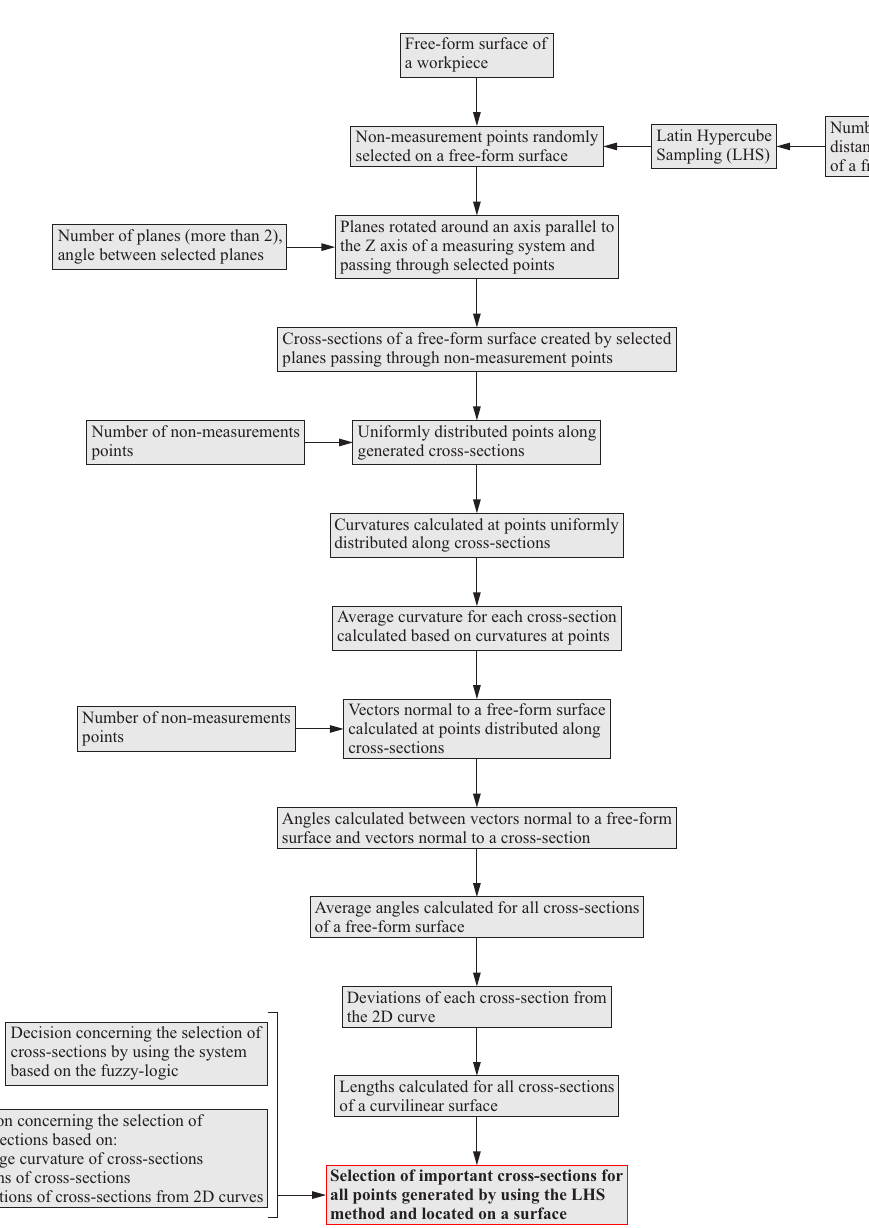
Figure 2. Algorithm of the distribution of scanning lines on a free-form surface of a